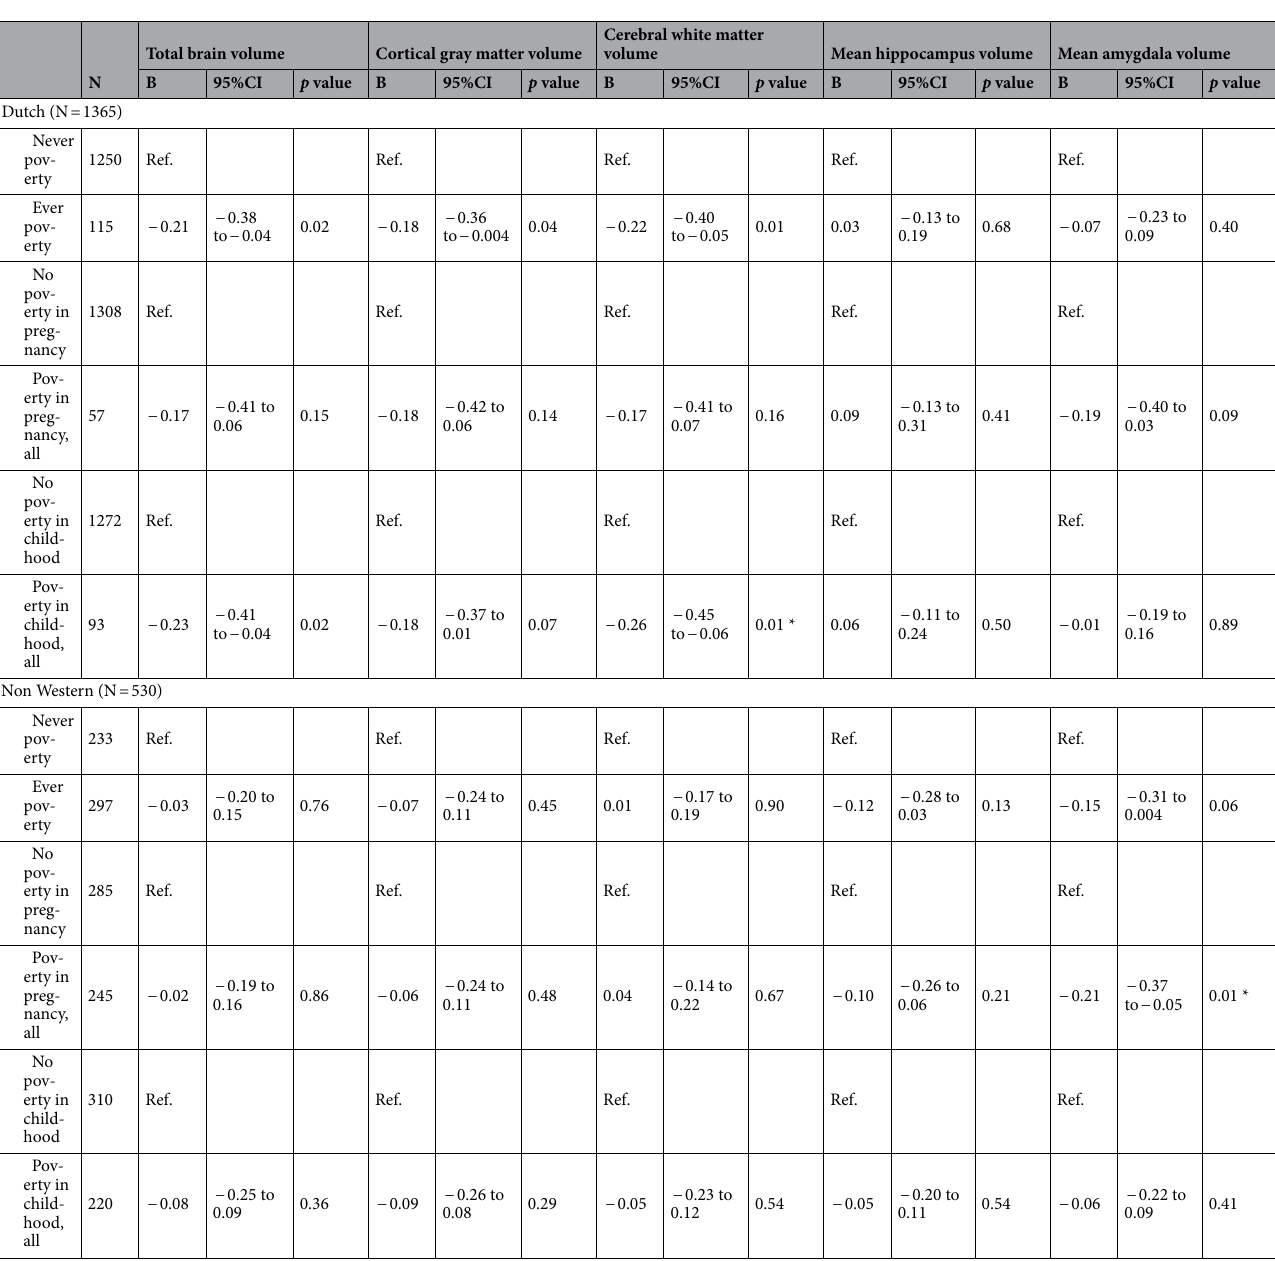
Table 4. the association of poverty wth brain morphology among children of Dutch majority and non- Western minority ethnic groups (N = 1895). Models for Dutch adjusted for child age at brain measurement, child sex, maternal education at pregnancy, maternal IQ, maternal and paternal psychiatric symptoms at pregnancy. Models for non-Western adjusted for Dutch model covariates + detailed maternal ethnicity [Cape Verdean, Moroccan, Dutch Antillean, Surinamese, Turkish, African, middle and south American and Asian (except for Indonesian and Japanese)]. Models for subcortical regions additionally adjusted for total intracranial volume. All brain measures of outcome are standardized. Ever poverty is a total of "poverty in pregnancy only", "poverty in childhood only" and "chronic poverty". * indicates adjusted p values < 0.05. Adjusted p values are obtained by considering the multiple comparisons (four tests for ever, pragnant any and childhood any poverty) with the Benjamini–Hochberg false discovery rate